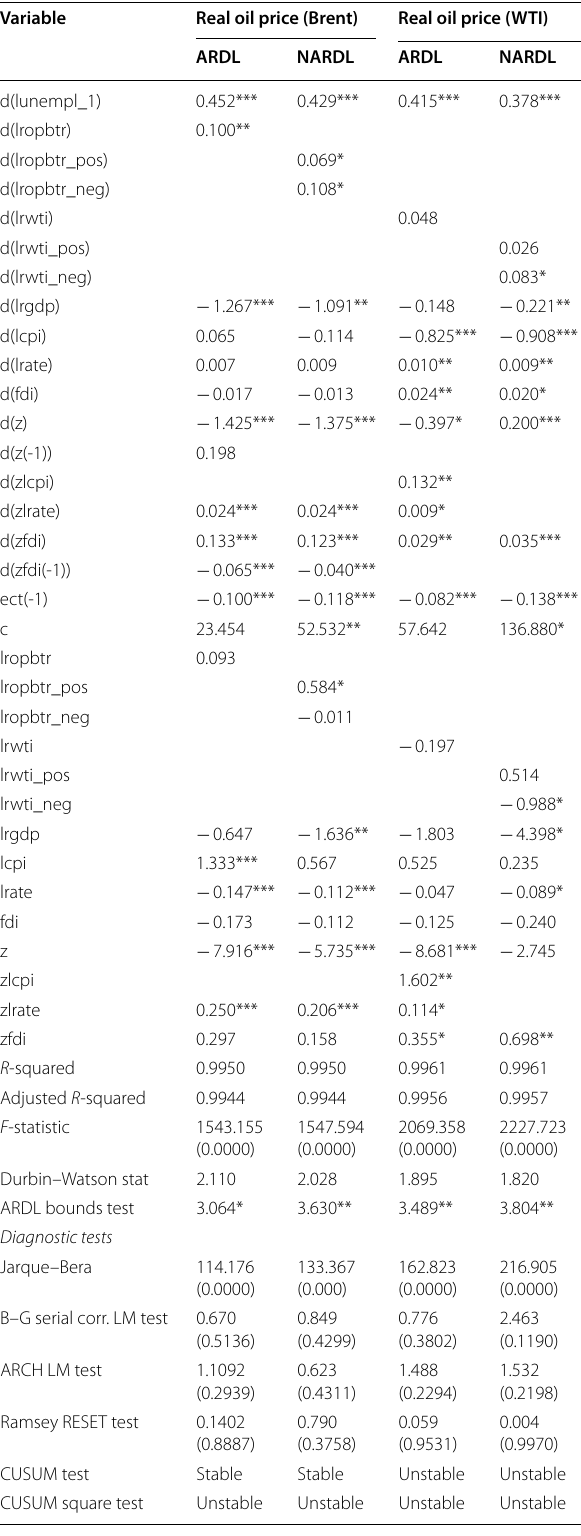
and nonlinear ARDL models of unemployment effect of oil price change with structural break. Source: Computed by the authors